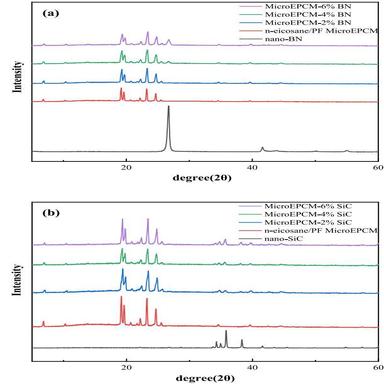
X-ray diffraction patterns of (a) MicroEPCM-BN; (b) MicroEPCM-SiC.